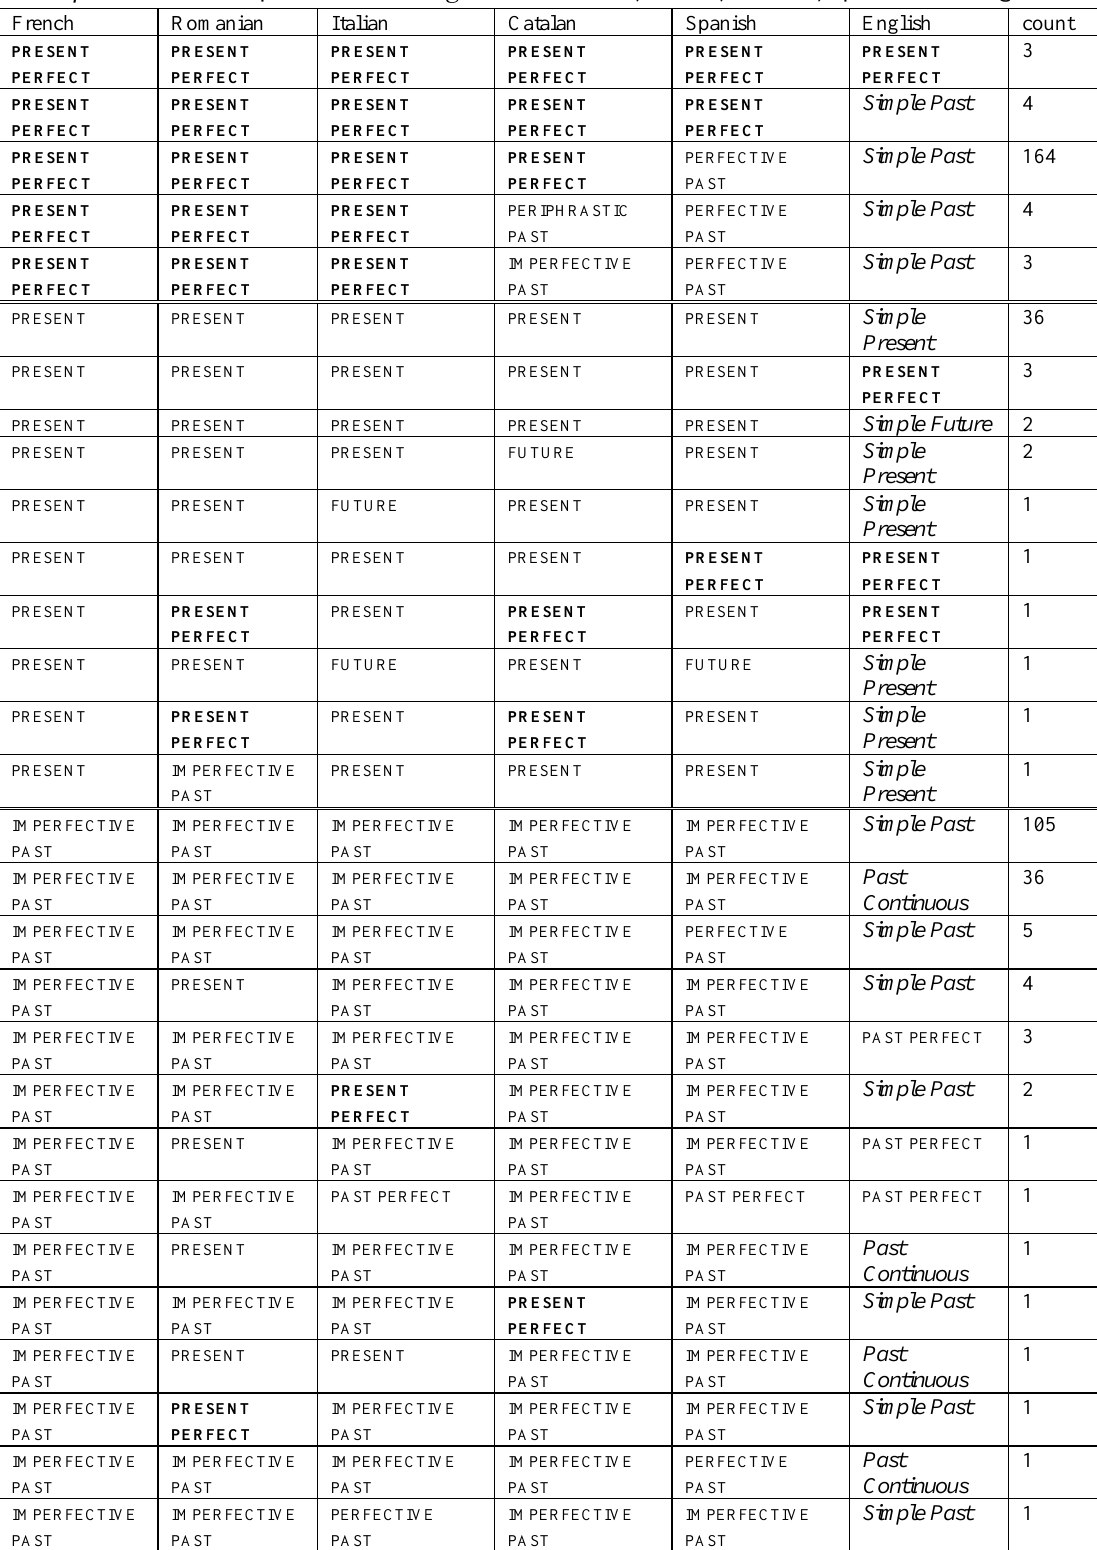
Table 3 . Distribution of tense-aspect categories in translations of the Passé Composé , Présent and Imparfait from Chapter 1 of L’Étranger in Romanian, Italian, Catalan, Spanish and English